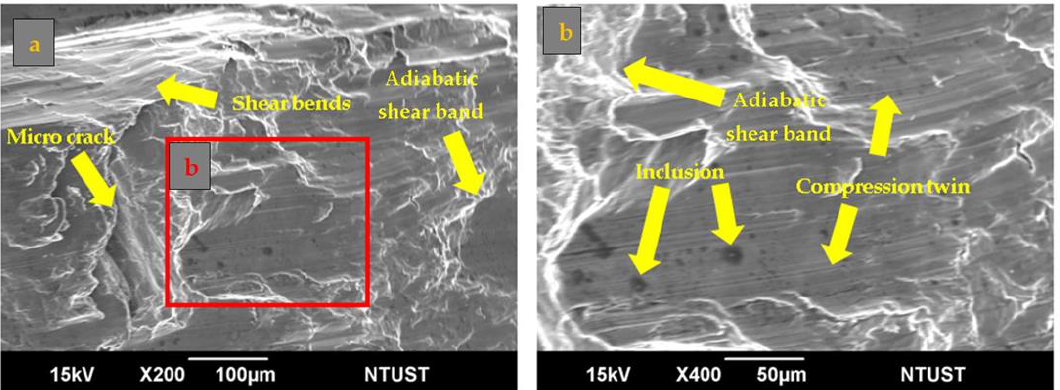
Figure 11. ( a ) The fracture surface morphology of 3% Nb 2 O 5 + AZ31. ( b ) Magnified fracture surface of figure ( a ).